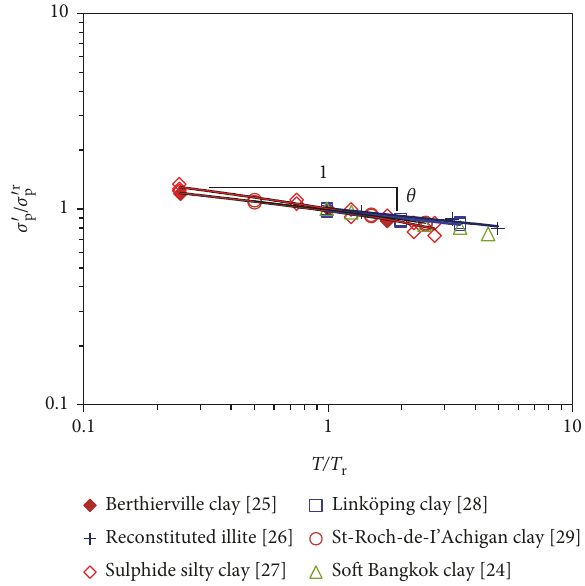
Figure 4: Temperature dependency of preconsolidation